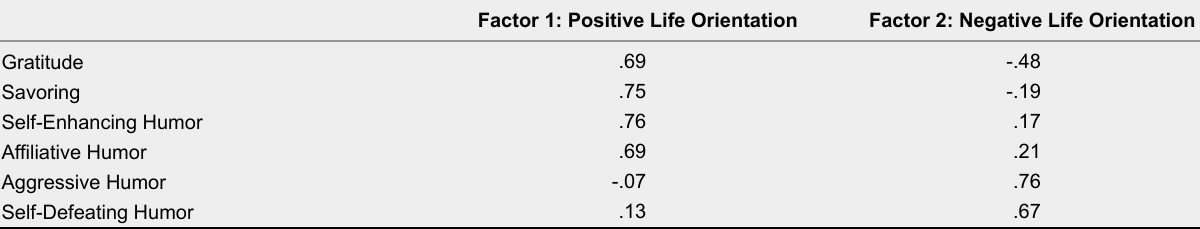
Factor Structure and Loadings for Humor Styles and Positive Psychology